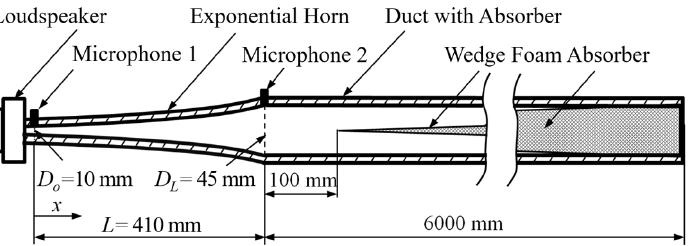
Figure 8. Experimental setup: loudspeaker, exponential horn, reflectionless termination with wedge foam absorber (6 m) to avoid backtraveling waves; microphones at x = 0, x = L [23].